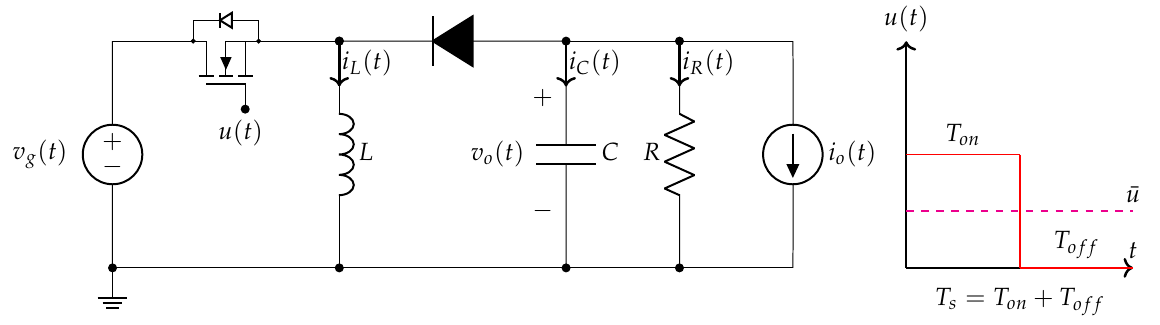
Figure 1. Schematic circuit of a buck-boost